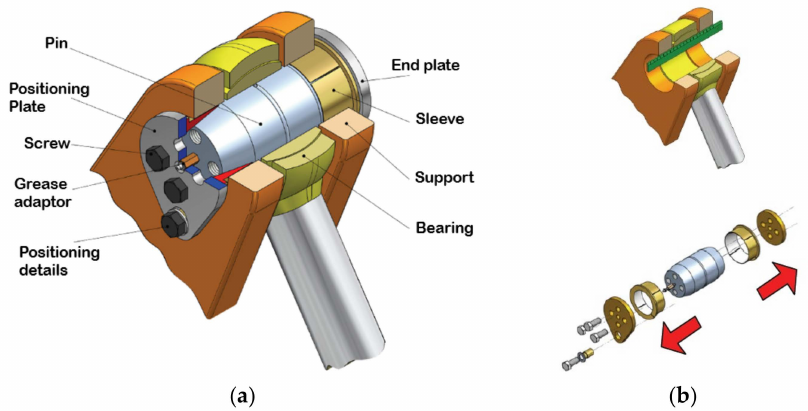
Figure 1. Illustration with section view of EPS. ( a ) EPS installed in a joint ( b ) Exploded